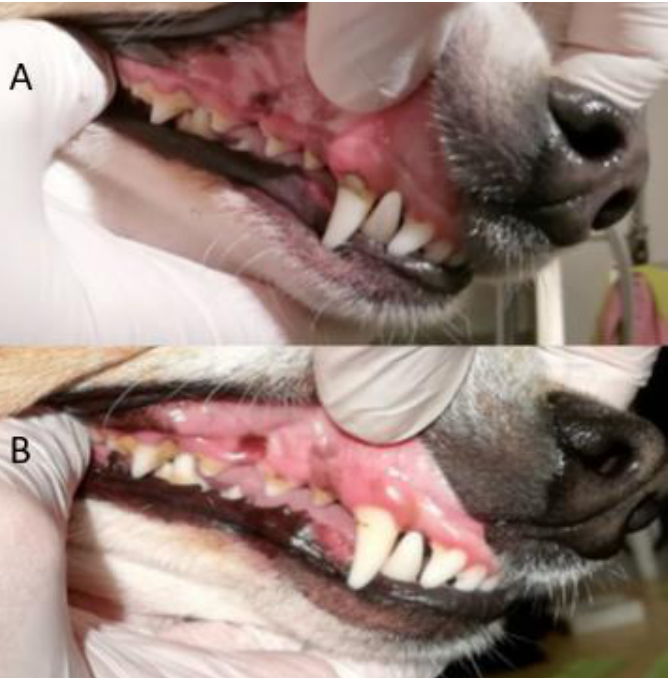
Figure 6. For dog ‘Textile 4′ the amount of calculus decreased during the study. ( A ): The teeth at the first assessment before the start of dental cleaning. Calculus can be seen on several teeth. ( B ): In this last assessment, calculus decreased on tooth 104 and, to some extent, on tooth 108 compared to ( A ) (Photo: Fanny Eriksson).